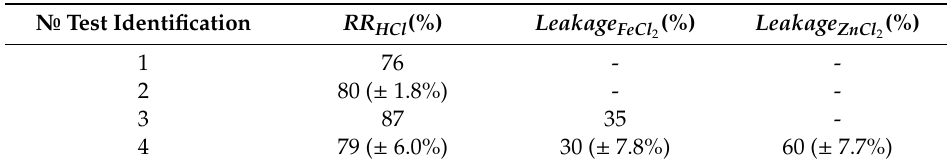
Table 3. Acid recovery and salt leakages for continuous operation tests. Values between brackets indicate the standard